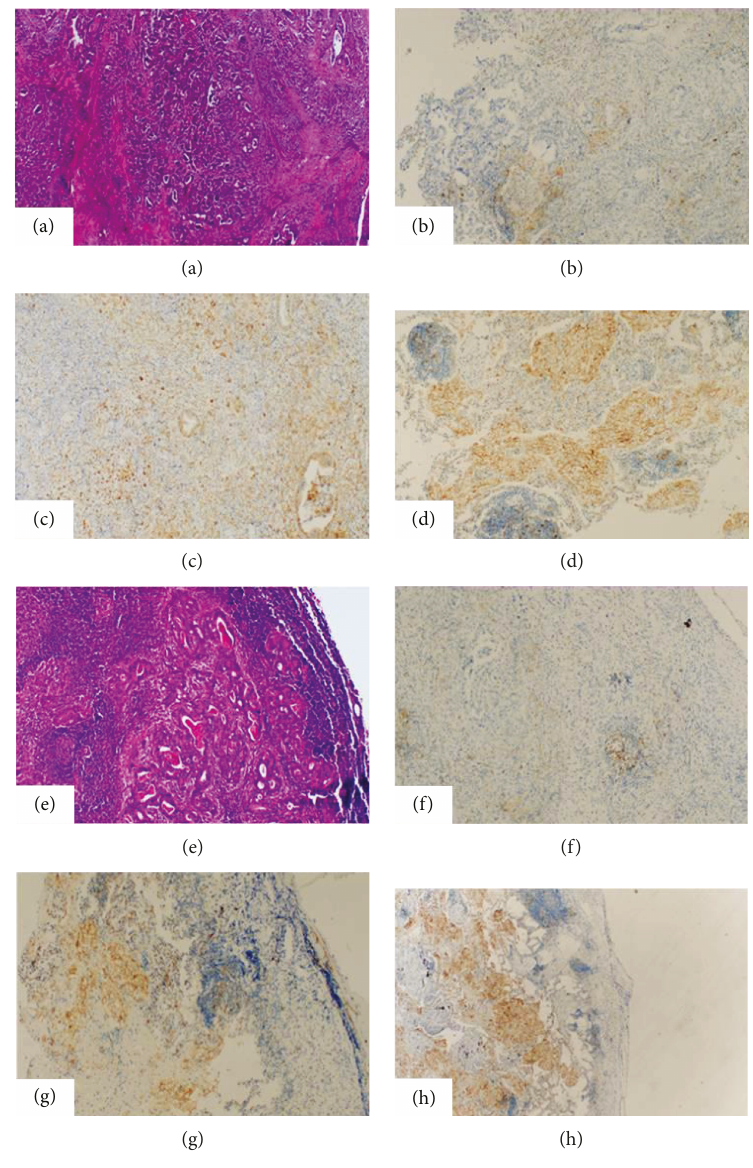
Figure 1: PDL-1 staining in primary tumor and metastatic lymph node in gastric cancer. (a) Gastric cancer primary tumor (HE). (b) Primary tumor (no PDL-1 staining). (c) Primary tumor (low PDL-1 staining). (d) Primary tumor (high PDL-1 staining). (e) Gastric cancer metastatic tumor (HE). (f) Metastatic tumor (no PDL-1 staining). (g) Metastatic tumor (low PDL-1 staining). (h) Metastatic tumor (high PDL-1 staining). All images × 100 magni fi cation. Table 2: Association of PDL-1 and MHC-1 expressions between primary tumor and metastatic lymph